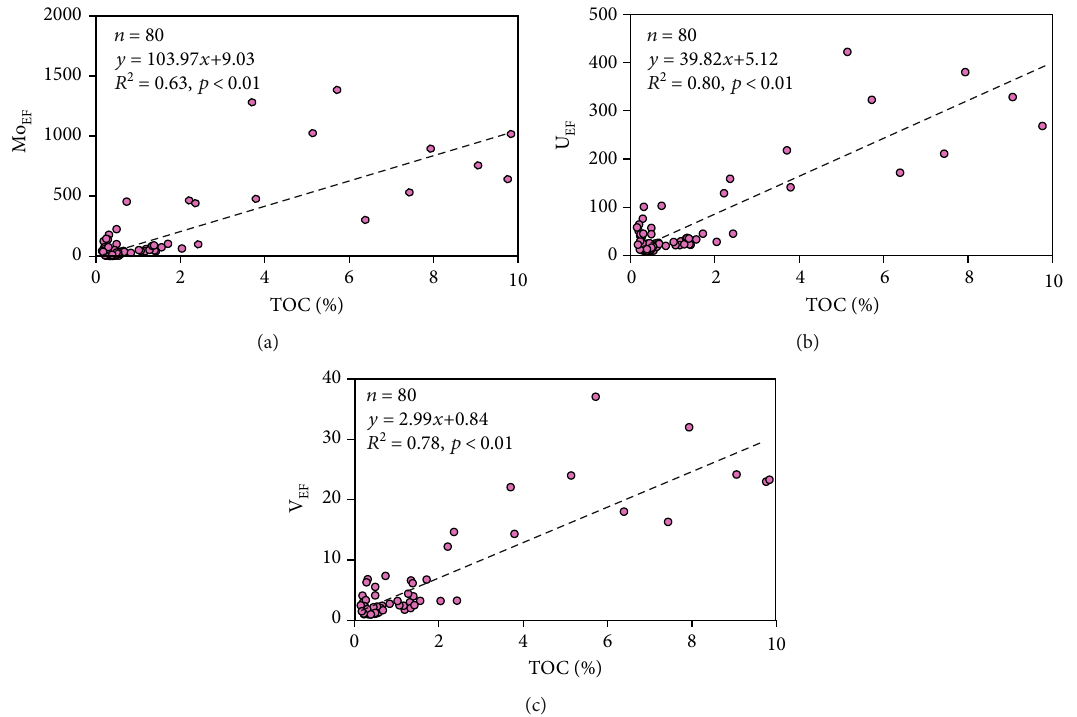
Figure 8: Crossplots of (a) Mo